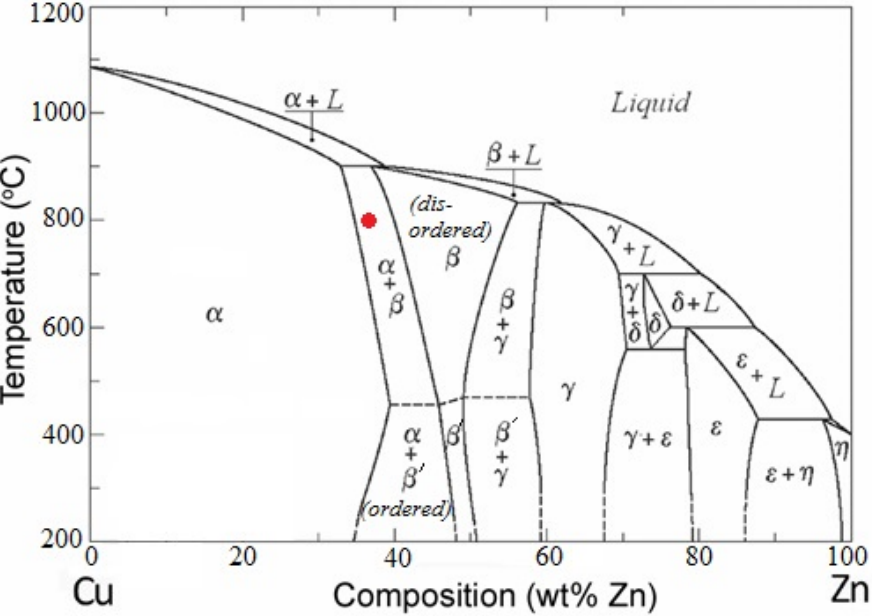
Figure 1. Cu–Zn binary phase diagram [3]. The area used for producing the α /disordered β double- phase brass is indicated by a red circle.